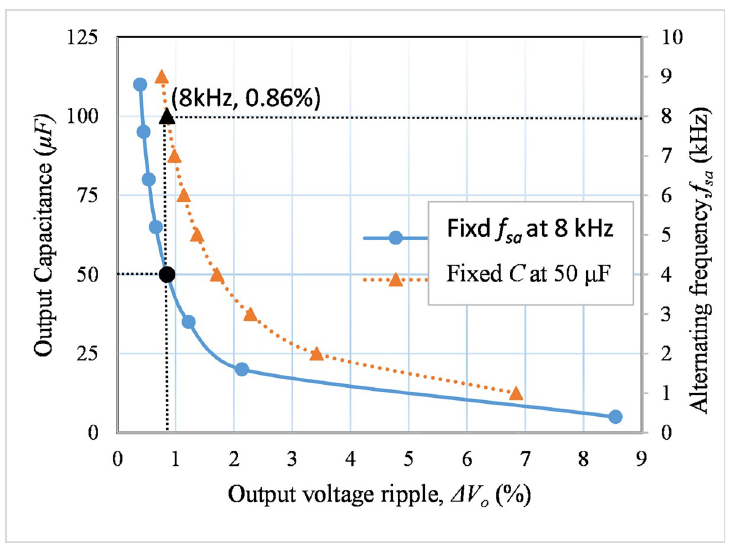
Fig 7. Output voltage ripple changes with the change in output